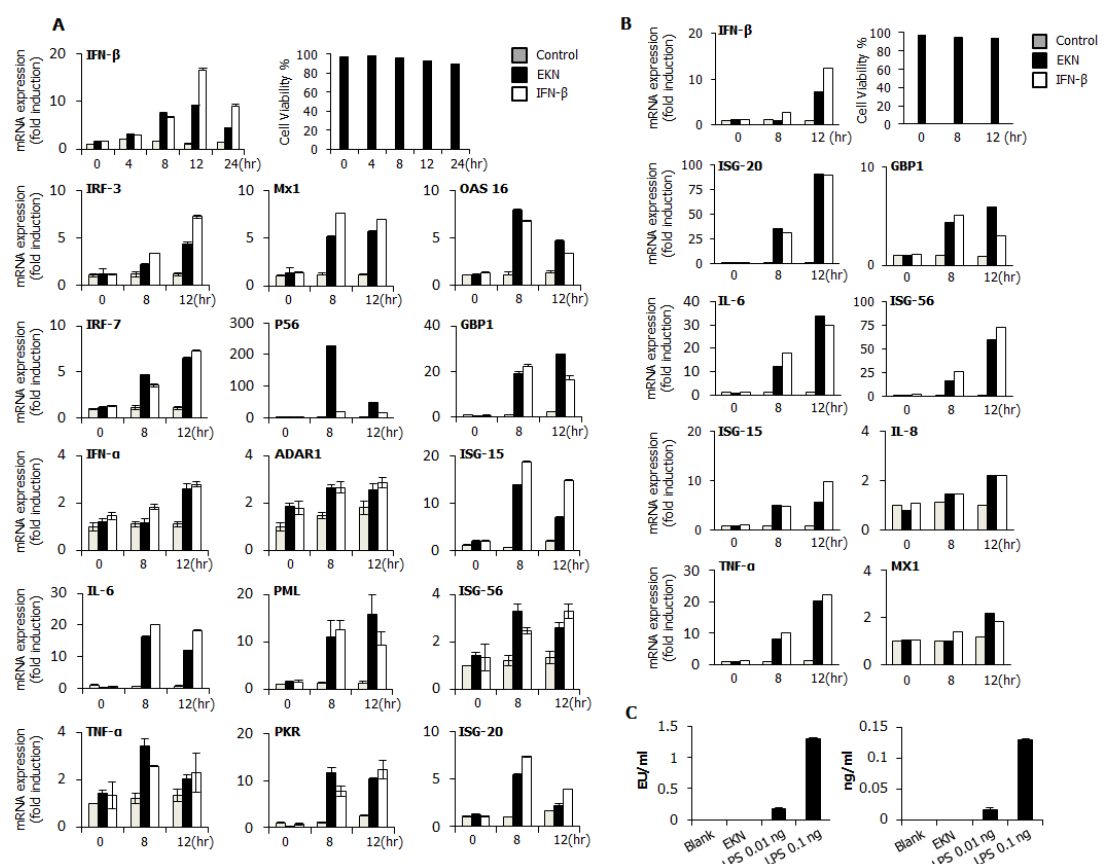
Figure 4. Induction of IFN-β, IFN-related gene and ISG’s transcripts by Epimedium koreanum Nakai in vitro . RAW264.7 and HEK293T cells were treated with DMEM + 10% FBS alone, Epimedium koreanum Nakai (EKN) (1.0 μg/mL), or 1000 units/mL of recombinant murine or human IFN-β. The time-dependent changes in mRNA expression after treatment in ( A ) RAW264.7; and ( B ) HEK293T cells were confirmed by real-time PCR using the primers shown in Tables 2 and 3. Real-time PCR was carried out with the use of a QuantiTect SYBR Green PCR kit (Qiagen) on a Mygenie96 thermal block (Bioneer). Error bars indicate